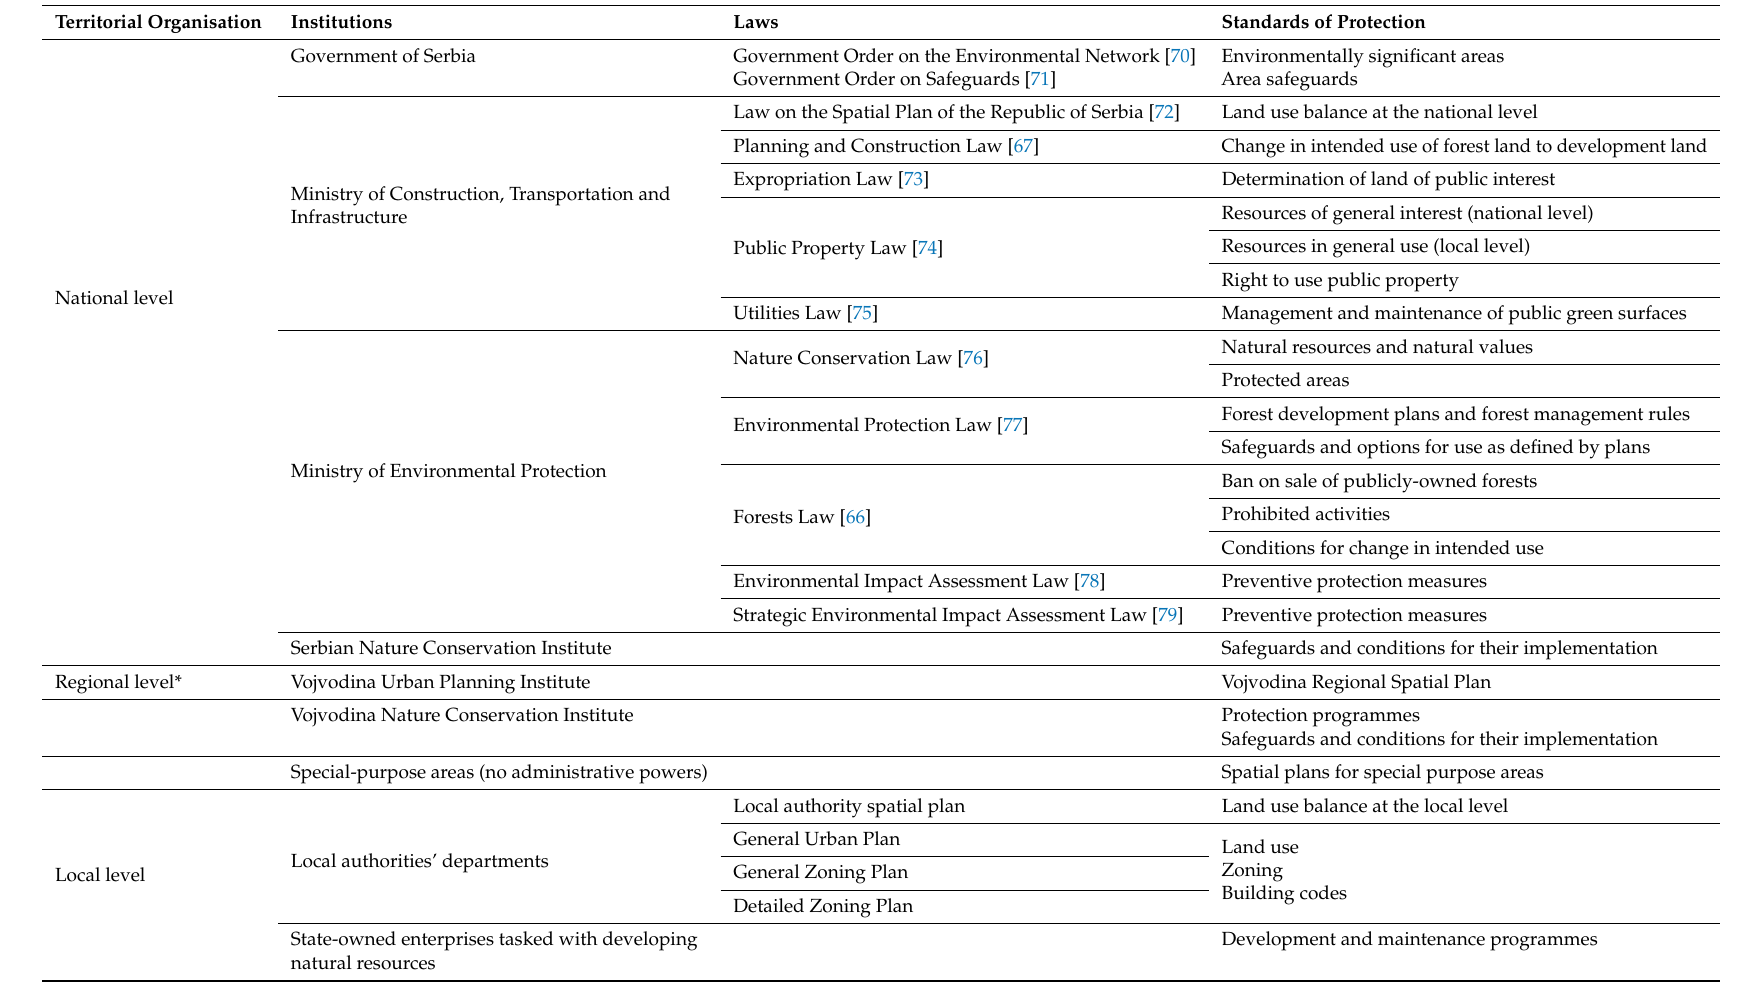
Table 1. Institutional and legal framework for standards of urban forest protection in